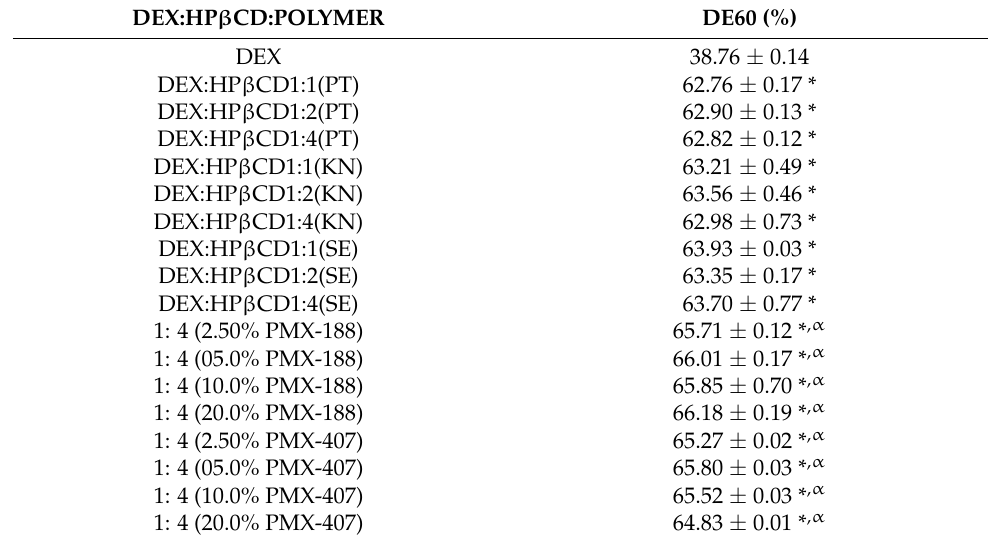
Table 4. Dissolution parameter of DEX and binary and ternary systems. Mean ± SD, n =